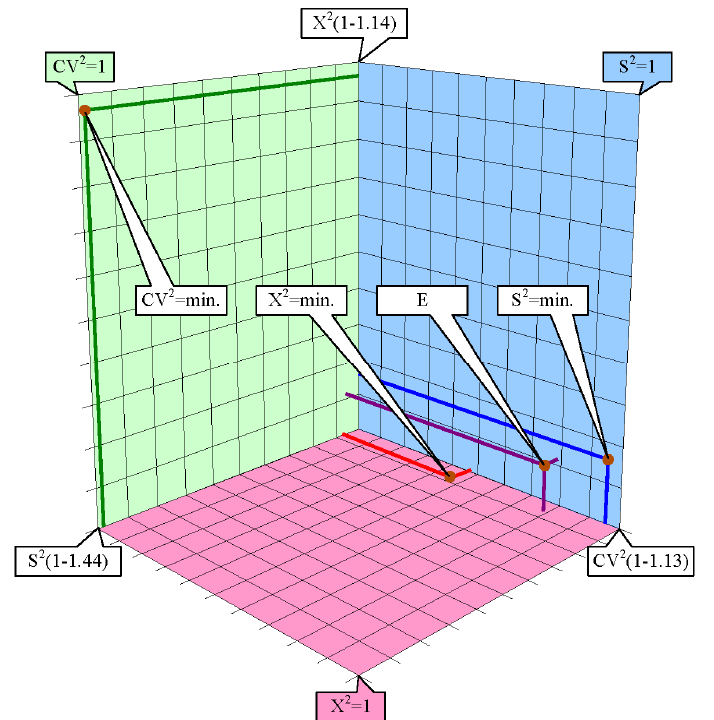
Figure 2. Position of empirical estimation (Equation (12)) within minimum relative errors (Equations